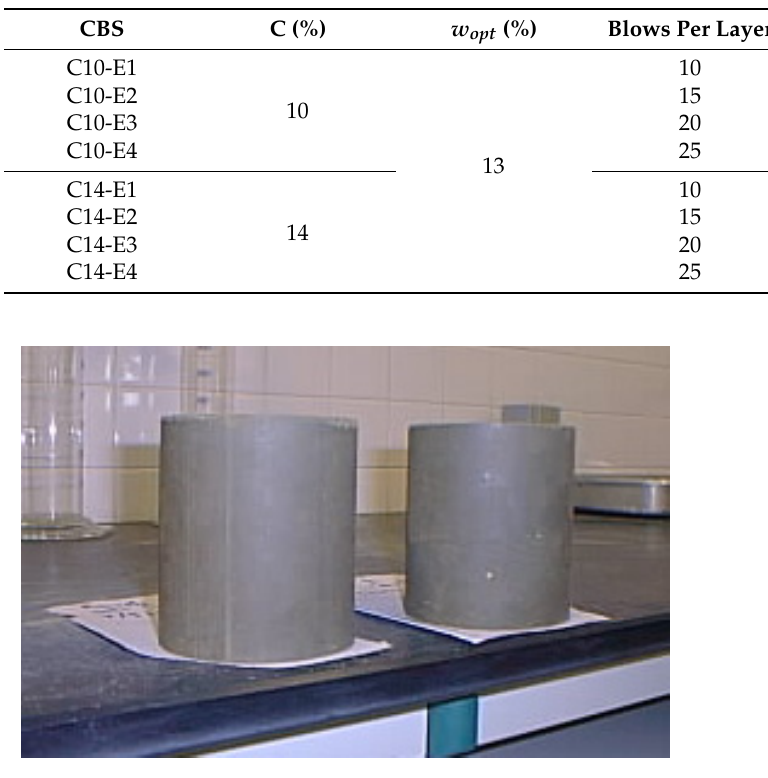
Figure 6. Cement-bound soil specimens.